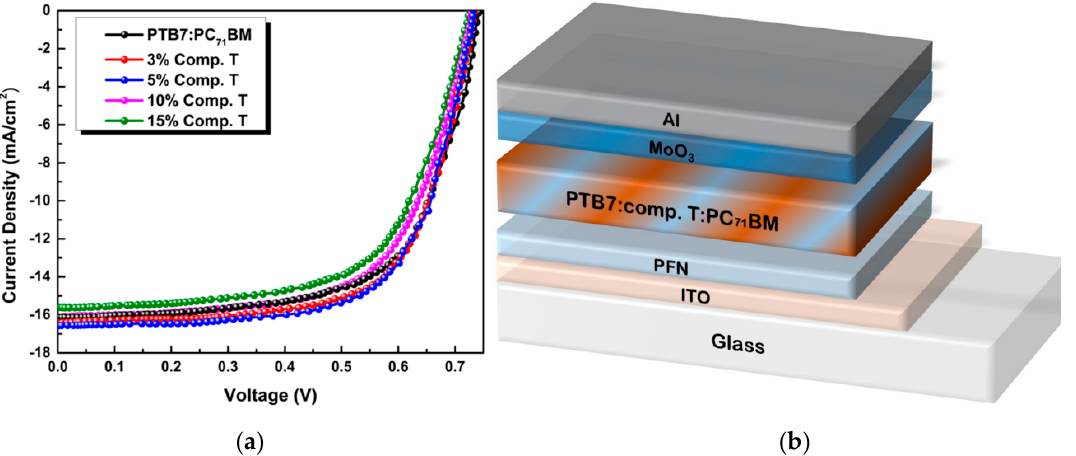
Figure 5. Current density to voltage characteristics of different concentrations of compound T in PTB7:PC 71 BM blend ( a ) and a schematic representation of the ternary bulk heterojunction device structure ( b ).